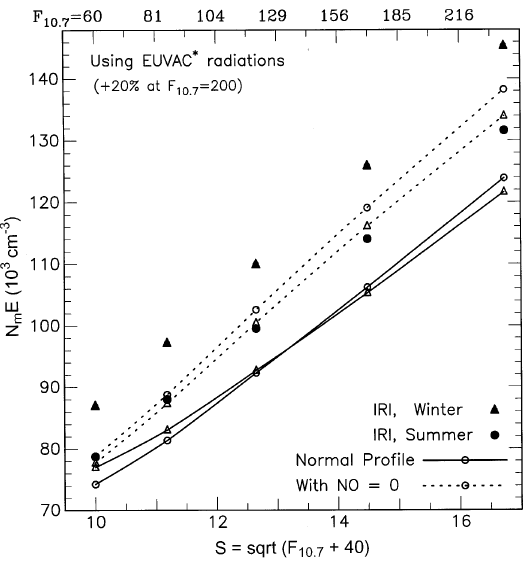
Fig. 8. Changes in N (cid:109) E obtained with different radiation models, using the full atmospheric model (with varying NO). The EUVAC model with a 20% increase in fluxes at high solar activity gives the broken line . The chain line gives results obtained using the modified Hinteregger radiations